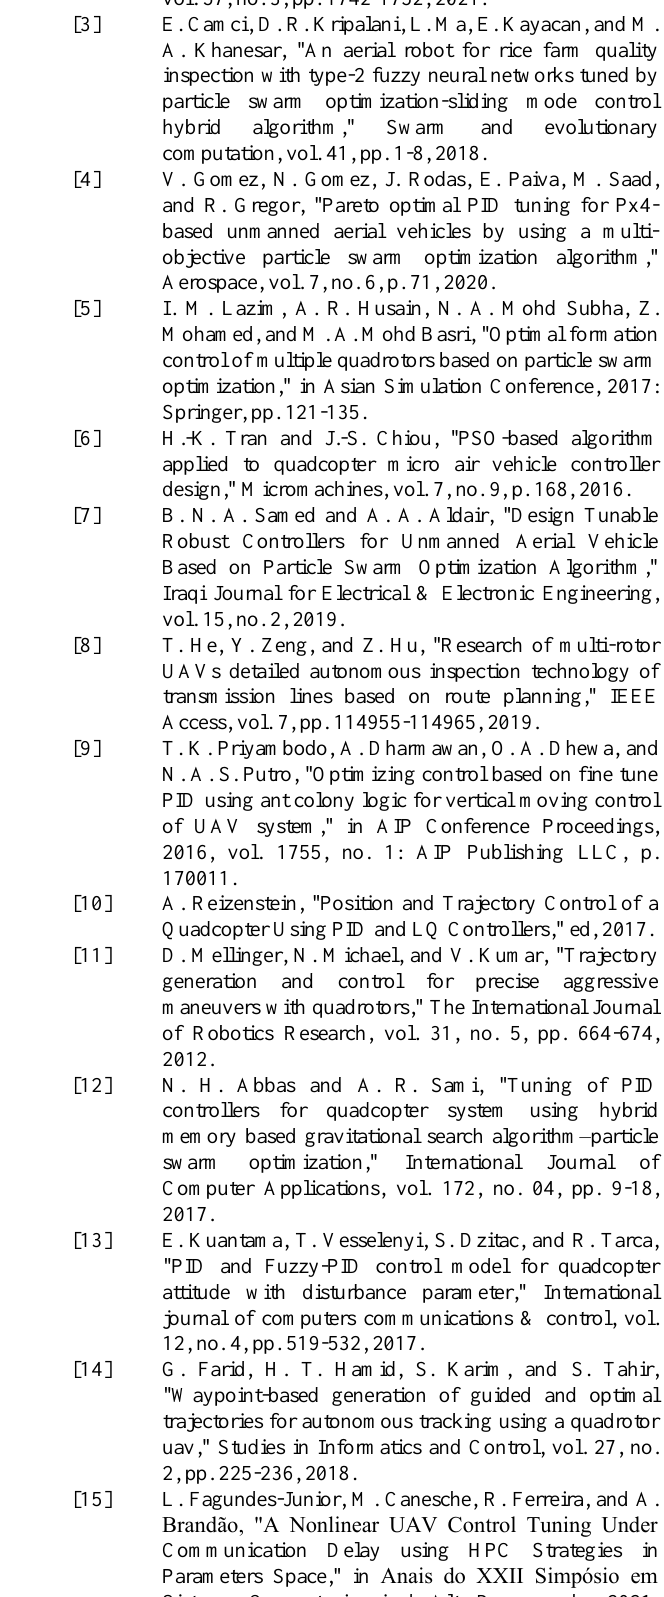
Figure 35. Plot angle vector without attitude controller